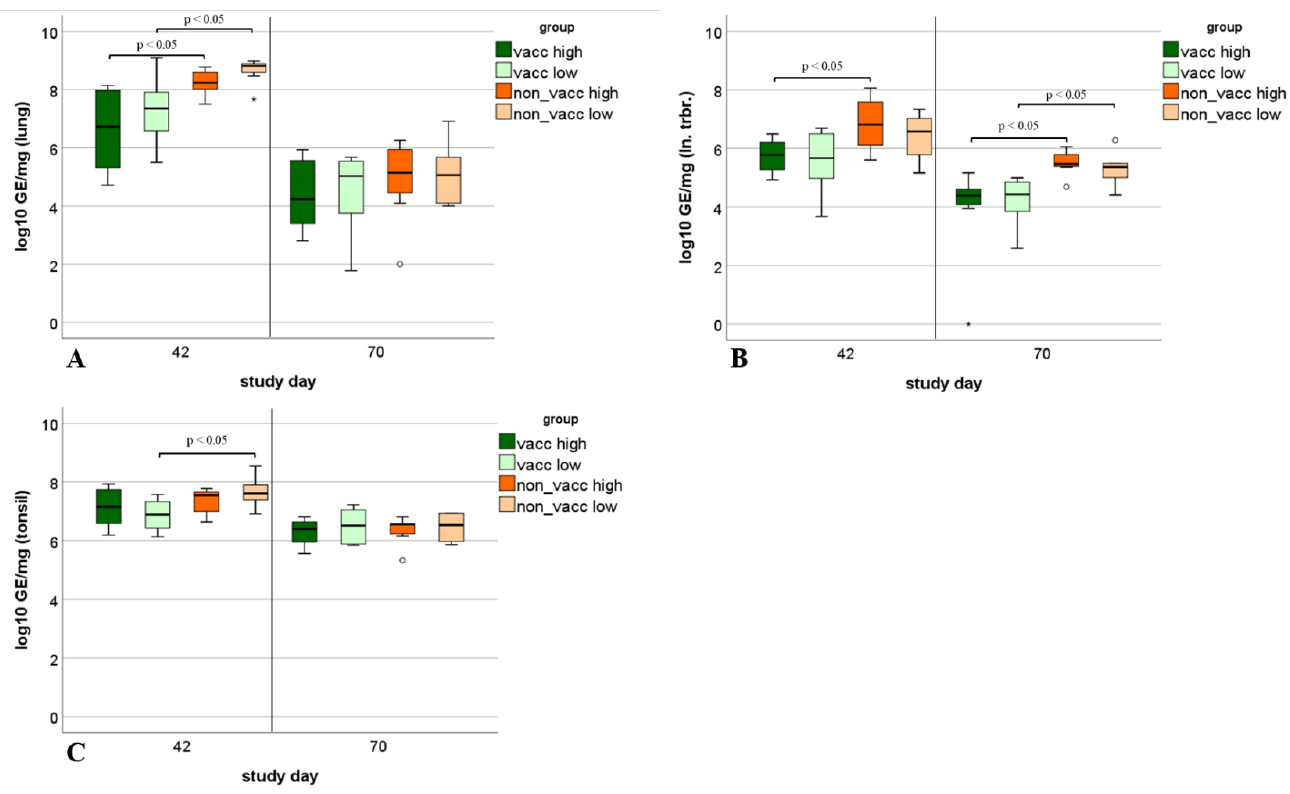
Figure 12. Viral load in tissue samples. Boxplots show 25th and 75th percentiles and median values, and whiskers show minimum and maximum values within 1.5 × interquartile range (IQR). Outliers are values with more than 1.5 × IQR (indicated using circles ◦ ), and extreme values are values with more than 3 × IQR (indicated using asterisks *). A : Viral load in lung tissue (log 10 GE/mg) from piglets necropsied on either study day 42 (first necropsy time point) or study day 70 (second nec- ropsy time point) in each infected treatment group (vacc high: vaccinated, high dose [10 5 TCID 50 /dose] infected; vacc low: vaccinated, low dose [10 3 TCID 50 /dose] infected; non-vacc high: non-vac- cinated, high dose infected; non-vacc low: non-vaccinated, low dose infected). Significant differ- ences ( p < 0.05) between vaccinated and non-vaccinated groups are indicated. B : Viral load in tra- cheobronchial lymph node (log 10 GE/mg) from piglets necropsied on either study day 42 (first nec- ropsy time point) or study day 70 (second necropsy time point) in each treatment group. Significant differences ( p < 0.05) between vaccinated and non-vaccinated piglets are indicated. C : Viral load in tonsils (log 10 GE/mg) from piglets necropsied on either study day 42 (first necropsy time point) or study day 70 (second necropsy time point) in each treatment group. Significant differences ( p < 0.05) between vaccinated and non-vaccinated piglets are indicated.